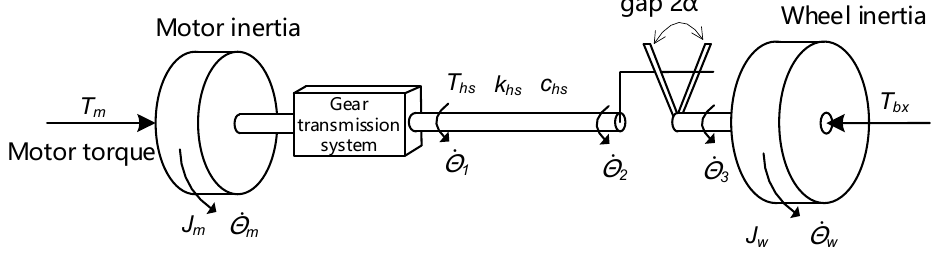
Figure 2. Simplified two-inertia model.